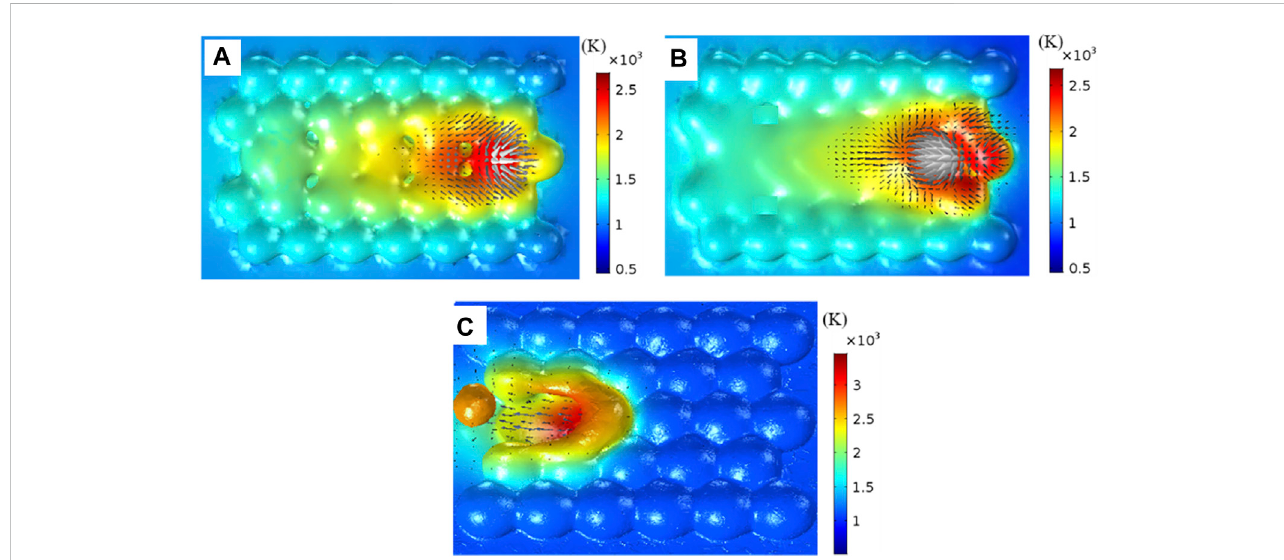
FIGURE 4 The temperature distribution of the molten track under various LED: (A) LED = 92 J/mm 3 , (B) LED = 229 J/mm 3 , (C) LED = 611 J/mm 3 , droplet spatter phenomenon on the top surface under LED = 611 J/mm 3 .